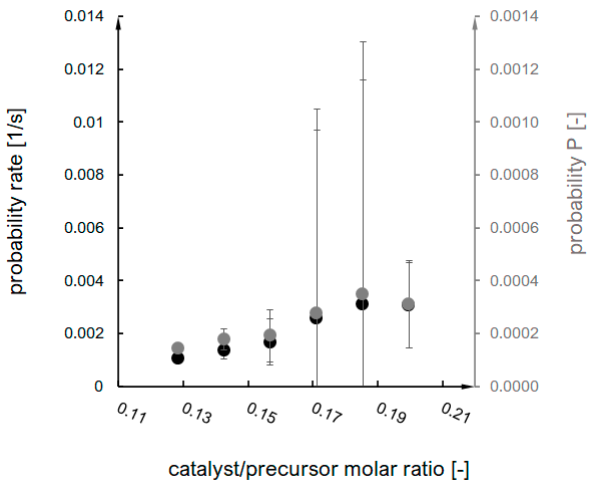
Figure 3. Designated values of 𝐸 (cid:3028) and 𝐴 constant as catalyst/precursor molar ratio function.